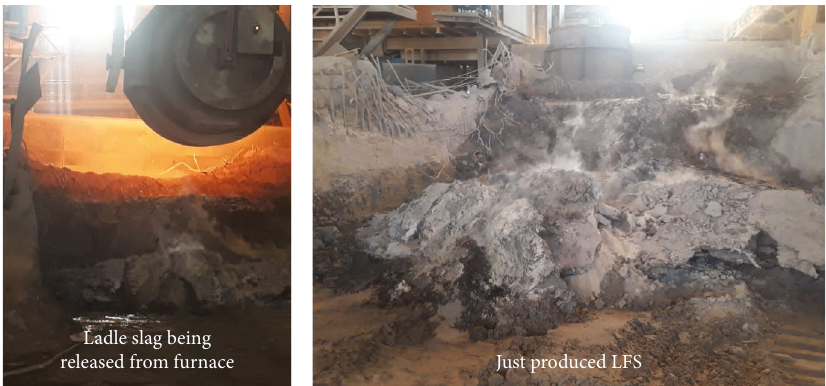
Figure 2: LFS as produced in Mirsarai plant of BSRM.